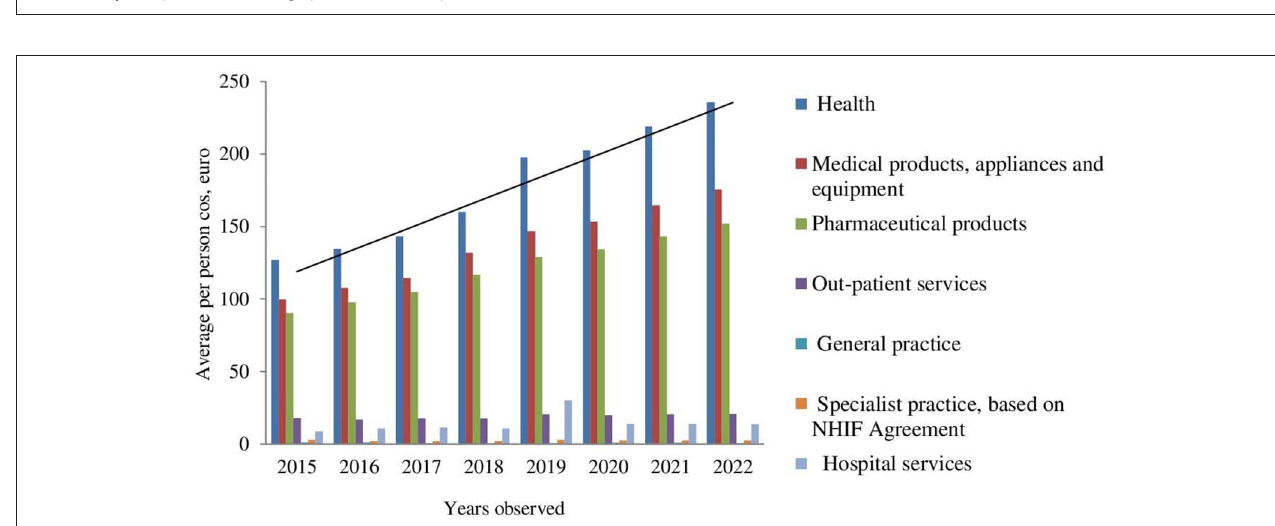
FIGURE 2 | Extrapolation of average per household expenditures.